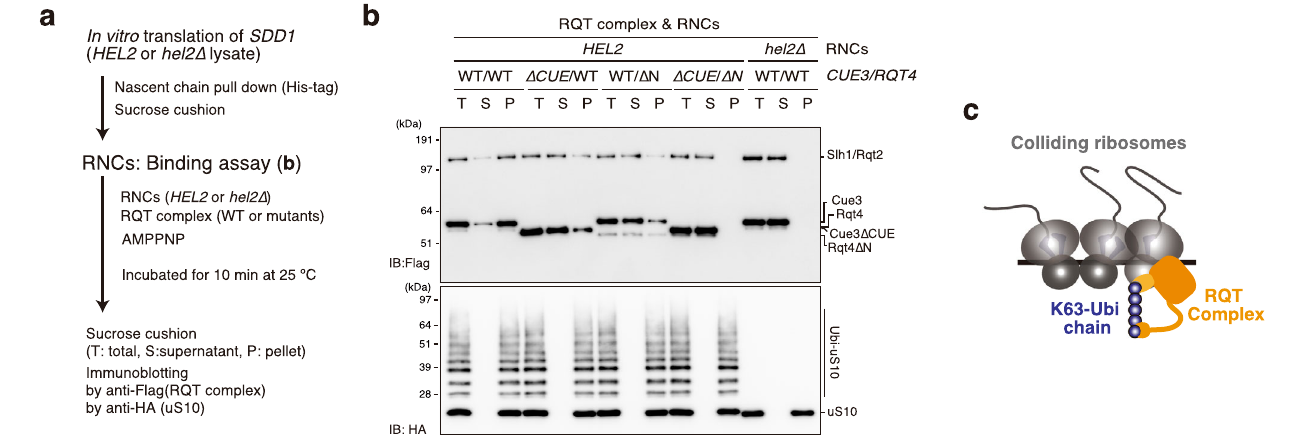
Fig. 5 | The recruitment of RQT complex into the colliding ribosome in the ubiquitin decoding-dependent manner. a Schematic of the experiments. b Binding assay between the colliding ribosome and the RQT complex. The ubi- quitinated or nonubiquitinated colliding ribosomes were prepared by HEL2 -con- taining or hel2 -knockout ( hel2 Δ ) IVT reaction and mixed with the indicated RQT complexinthepresenceofAMPPMPasdescribedin( a ).Afterthebindingreaction,